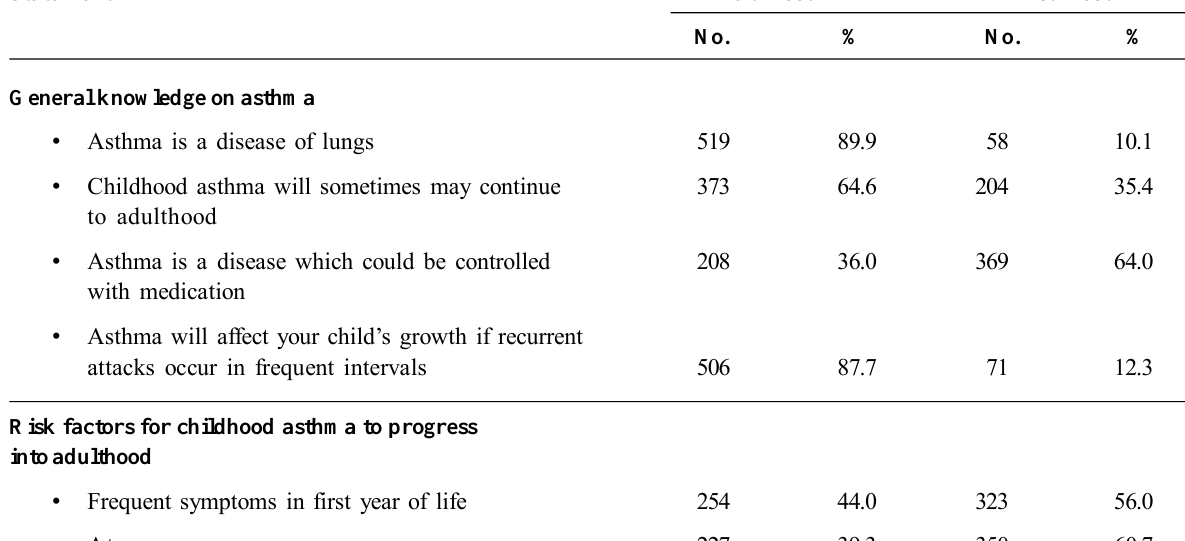
General knowledge on